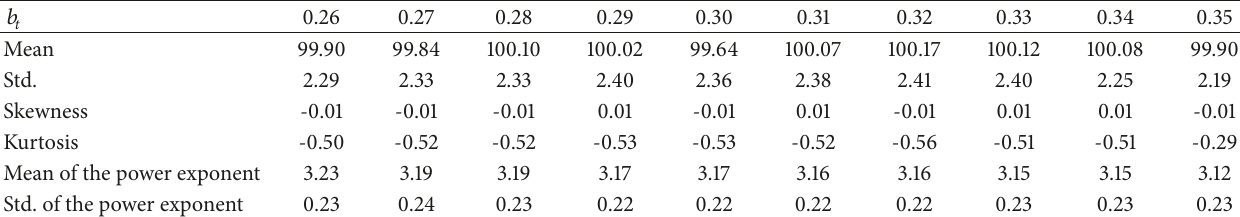
Table 3: Sensitivity analysis of the parameter of exponential distribution 𝑏 𝑡